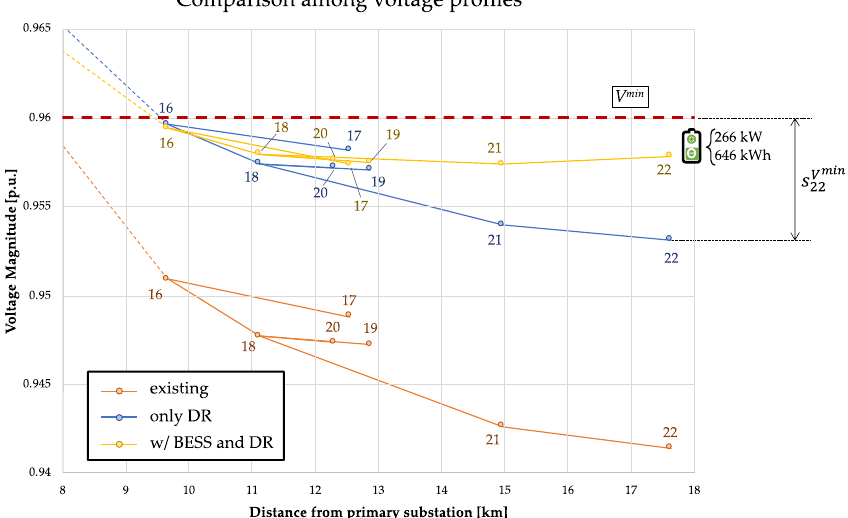
Figure 11. Ending part of F2 voltage profile with and without BESS when B cap = 40 k€ ( 𝜀 𝑛𝑝𝑟𝑖𝑜 = 10% ).